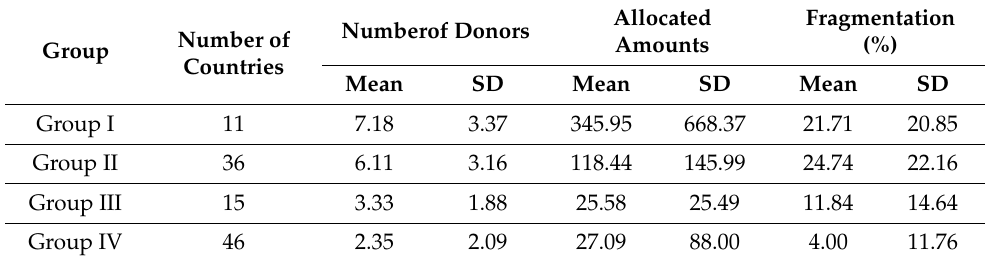
Table 7. Groups of recipient countries by REDD+ progress.